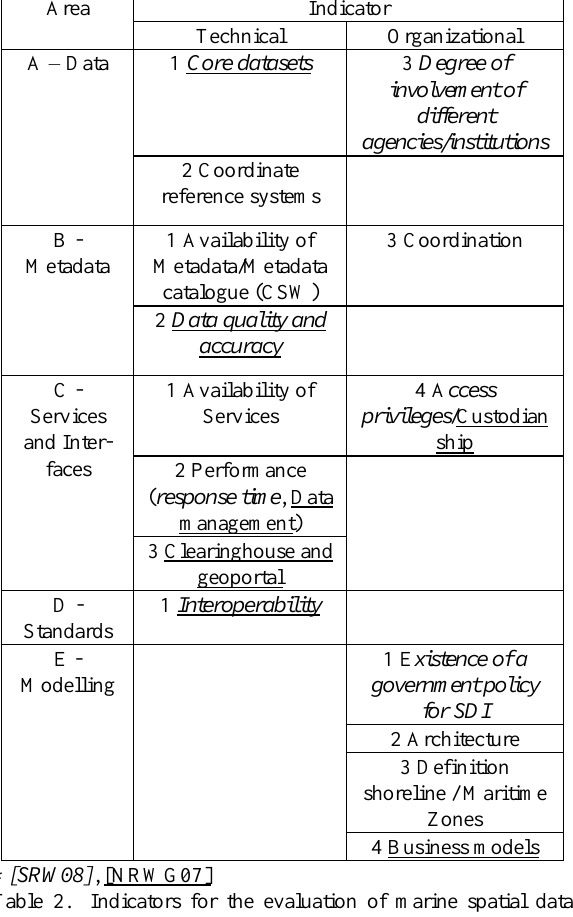
Table 2. Indicators for the evaluation of marine spatial data